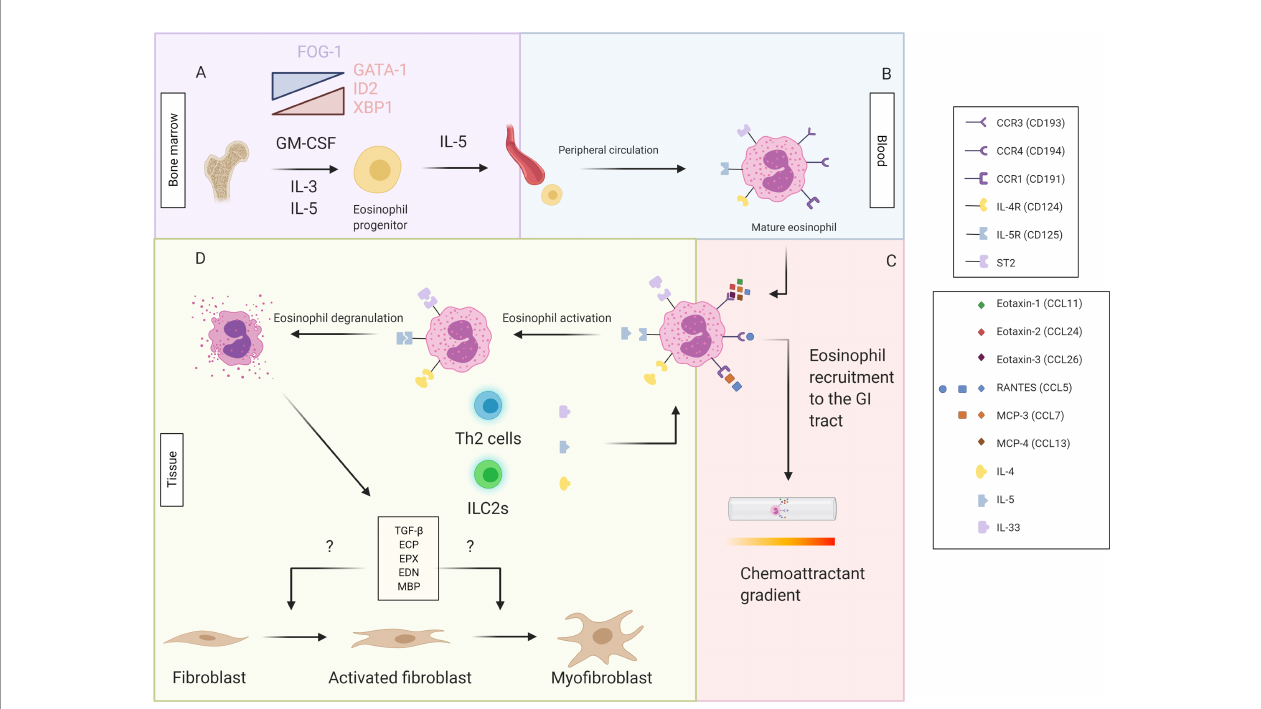
FIGURE 1 | Pluripotent hematopoeitic stem cells differentiate from the bone marrow to eosinophil progenitors in response to GM-CSF, IL-3, IL-5, a decrease in transcription factor FOG-1 and increased presence of the transcription factors GATA-1, ID2 and XBP1 (A) . Under the in fl uence of IL-5 the eosinophil progenitor will be released in the peripheral circulation and further develop into mature eosinophils in the blood (B) . By the binding of the chemoattractants (eotaxin-1, eotaxin-2, eotaxin-3, MCP-3, MCP-4 and RANTES) to the chemoattractant receptors (CCR1, CCR3 and CCR4) a chemoattractant gradient is created and the mature eosinophils are recruited to the GI tract (C) . The binding of the cytokines IL-4, IL-5 and IL-33, primarily produced by the Th2 cells and ILC2s, to their respective receptor (IL-4R or CD124, IL-5R or CD125 and ST2) causes eosinophil activation and subsequent degranulation releasing TGF-ß, ECP, EPX, EDN and MBP. These factors possibly in fl uence fi broblast activation and differentiation from fi broblasts to myo fi broblasts (D) . This fi gure was created via